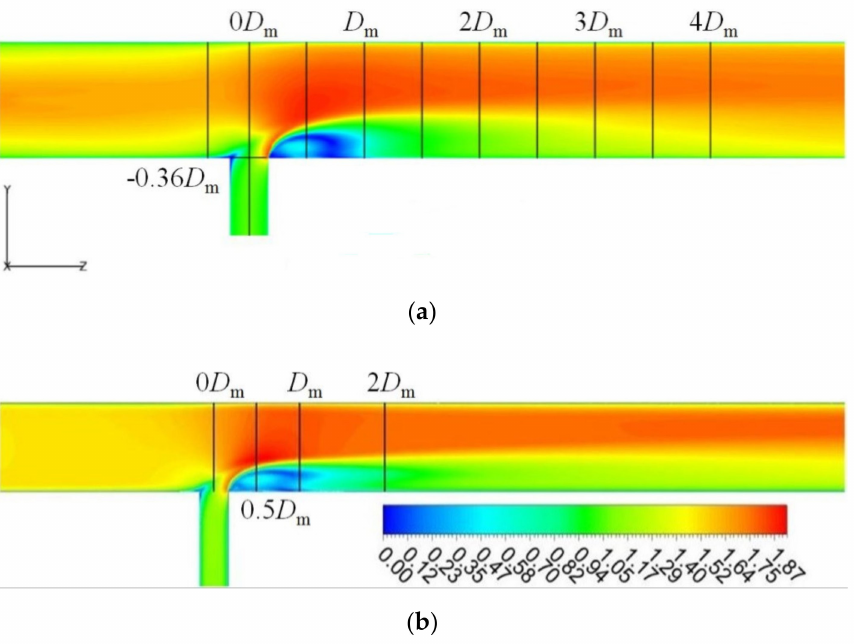
Figure 6. Absolute averaged velocity distribution (in m/s) in the middle section of the T-junction at